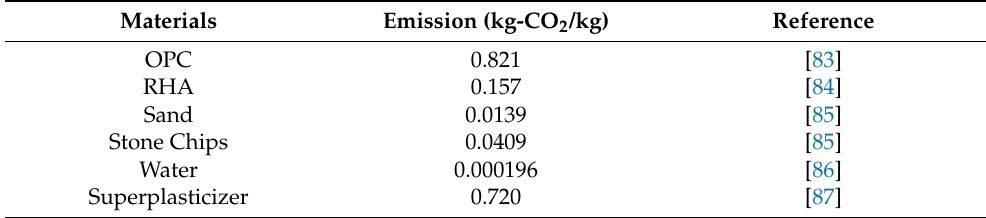
Table 7. CO 2 emissions data for